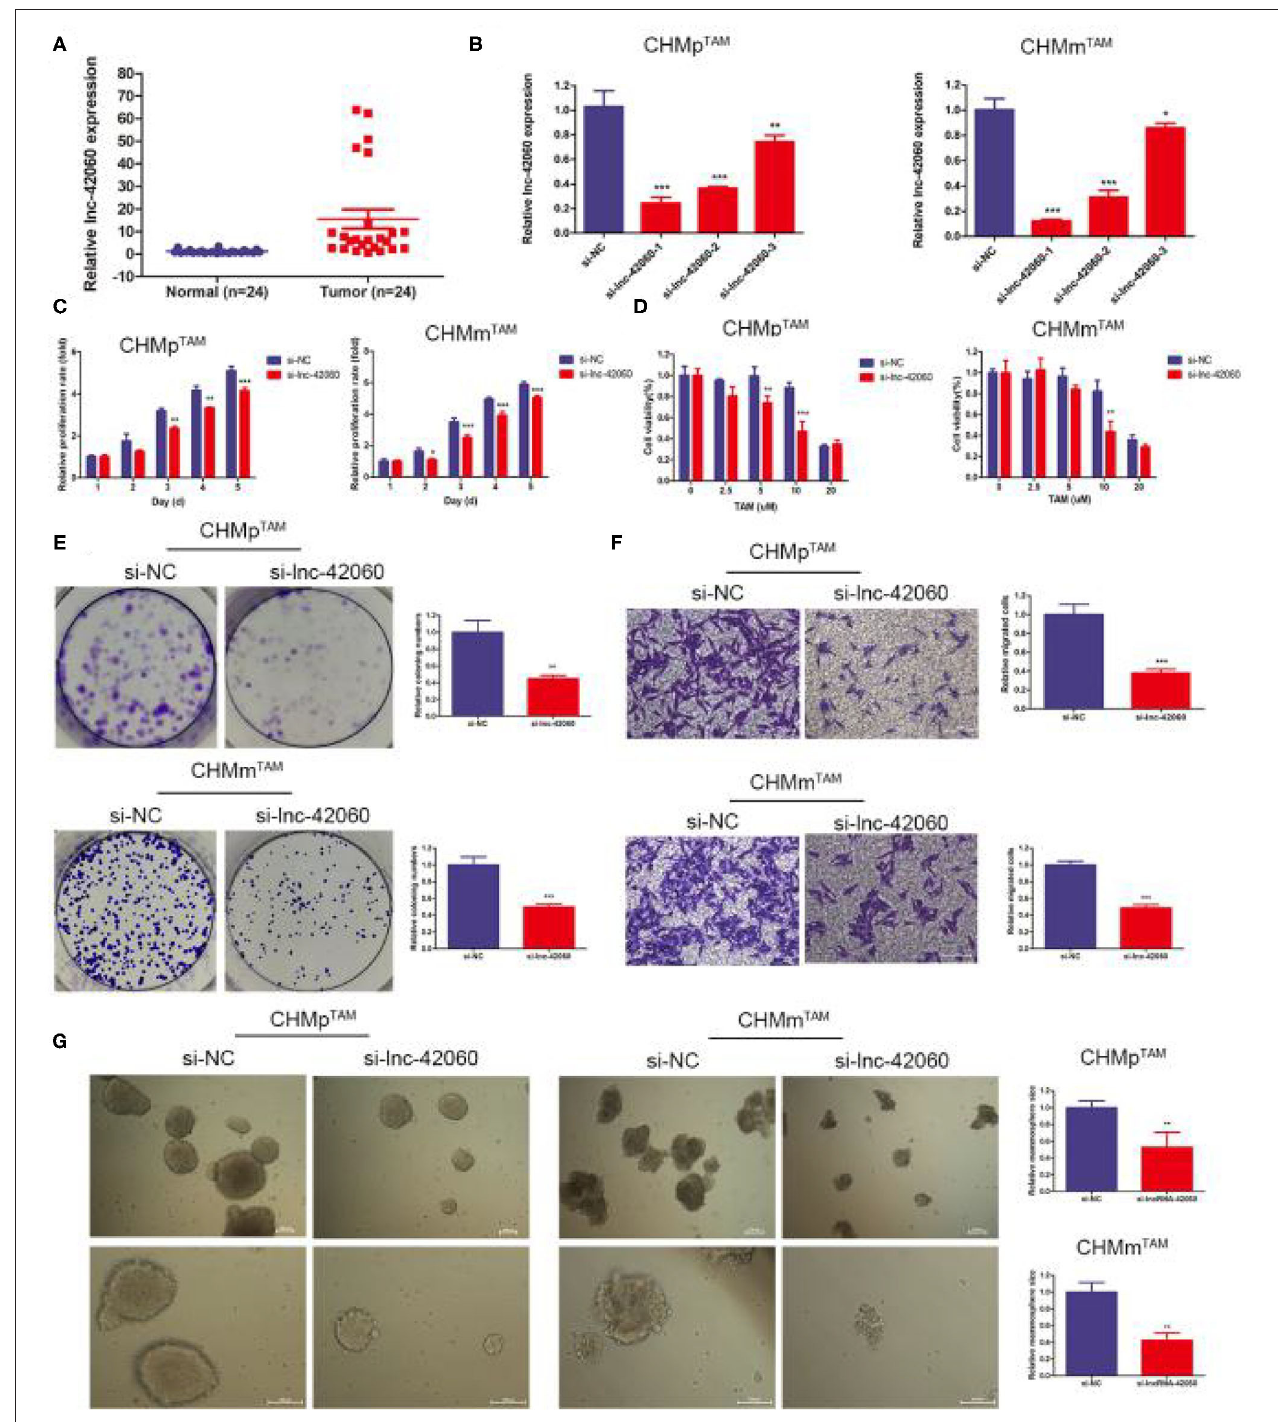
FIGURE 2 | Silencing lnc-42060 inhibited cell proliferation, migration and restored TAM sensitivity in TAMRs. (A) Expression of lnc-42060 in CMGT and normal tissues by qRT-PCR. (B) The expression of lnc-42060 and GAPDH in TAMRs was determined with qRT-PCR transfected with the negative control of siRNA (si-NC) and si-lnc-42060-1/2/3. (C) CCK8 assay was conducted to evaluate cell proliferative ability in TAMRs/si-NC and TAMRs/si-lnc-42060. (D) CCK8 assay shows the variation in TAM sensitivity in TAMRs/si-NC and TAMRs/si-lnc-42060. (E) Colony formation is shown in TAMRs /siNC and TAMRs/si-lnc-42060. (F) Transwell migration was conducted to evaluate cell migration ability (magnification, 200 × ) in TAMRs/si-NC and TAMRs/si-lnc-42060. (G) Microemulsion size in TAMRs/si-NC and TAMRs/si-lnc-42060 (magnification, 100 and 200 × ). Data are presented as means ± SD of at least three independent experiments. Compared with control group, * P < 0.05, ** P < 0.01, *** P <